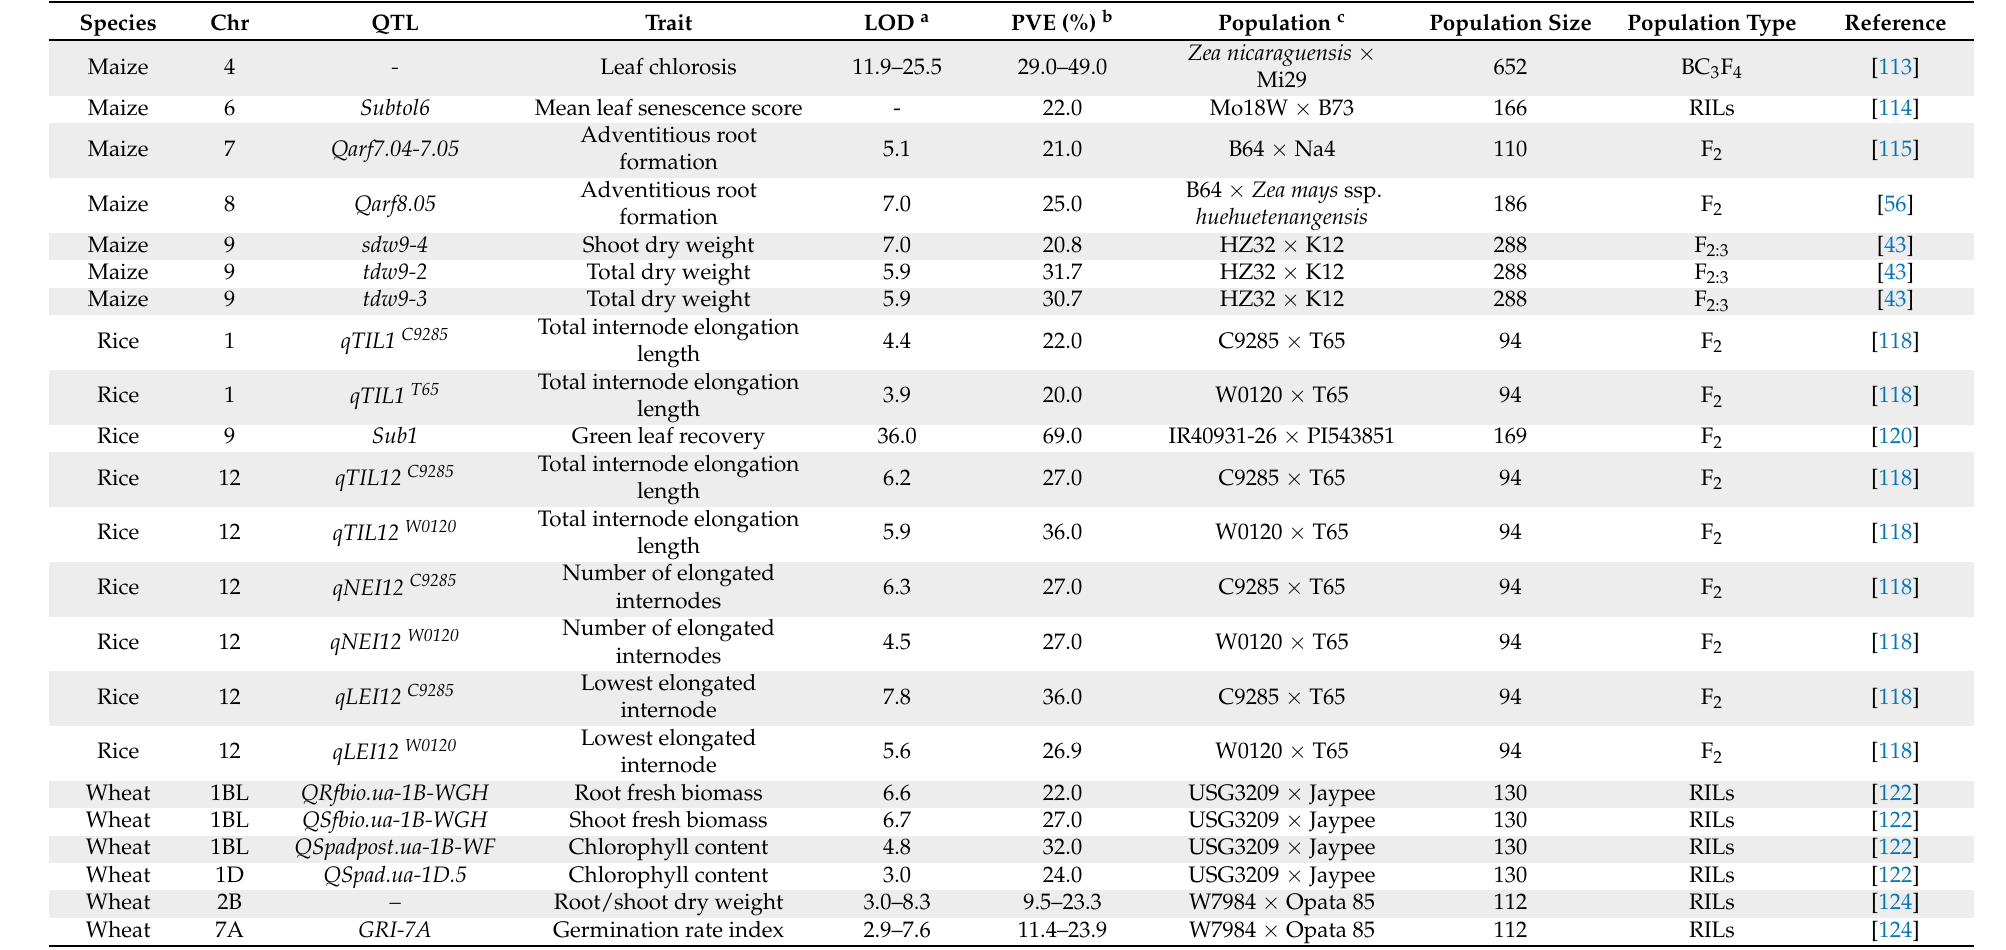
Table 1. Summary of major QTLs associated with waterlogging tolerance in maize, rice, wheat, and